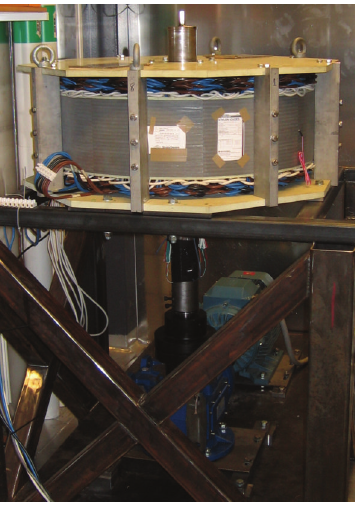
Figure 4: Permanent magnet synchronous generators used in the experimental setup.